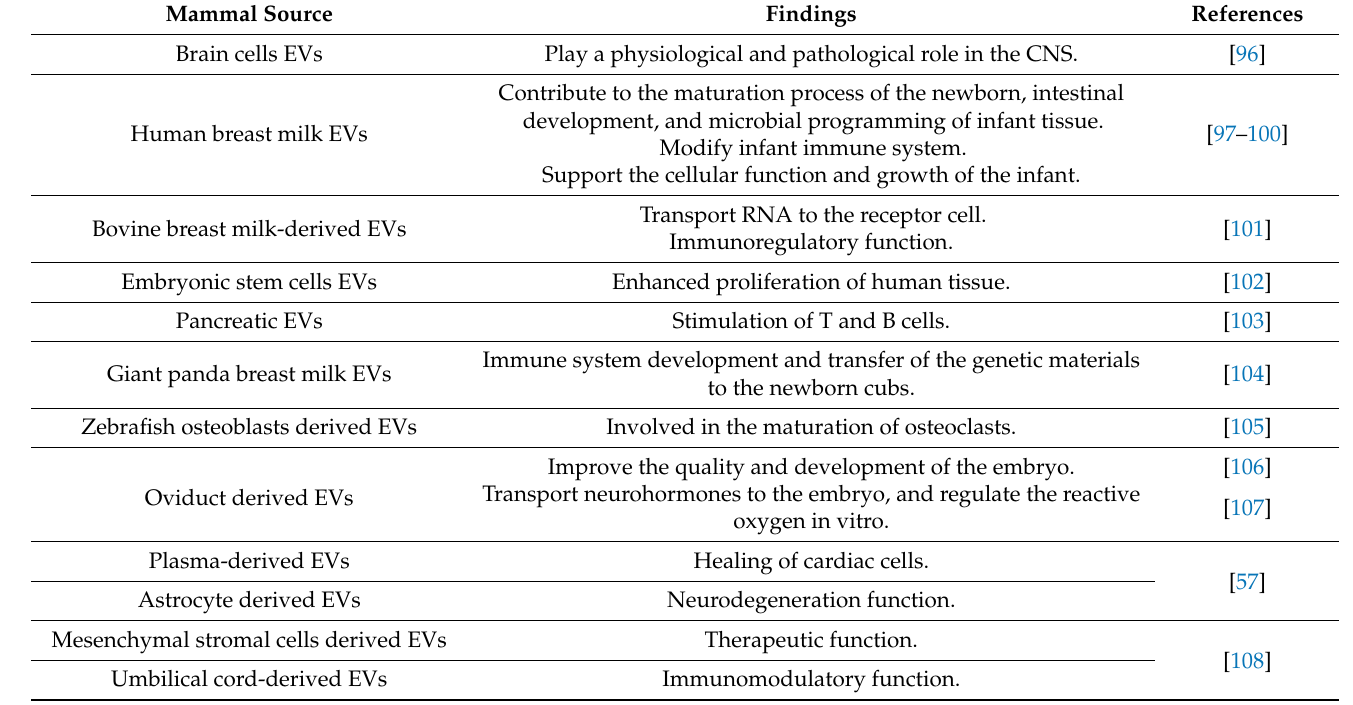
Table 3. Mammal-derived EVs were thoroughly investigated; their involvement in several pathologi- cal and physiological functions was recorded in various studies. Mammal Source Play a physiological and pathological role in the CNS. Contribute to the maturation process of the newborn, intestinal development, and microbial programming of infant